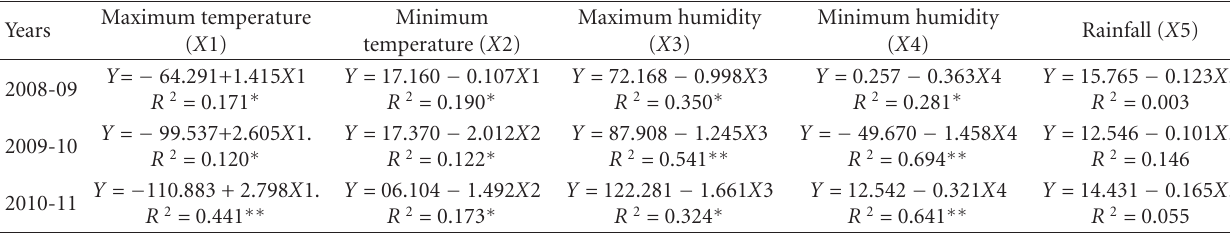
Table 3: Regression model developed for Leaf roller